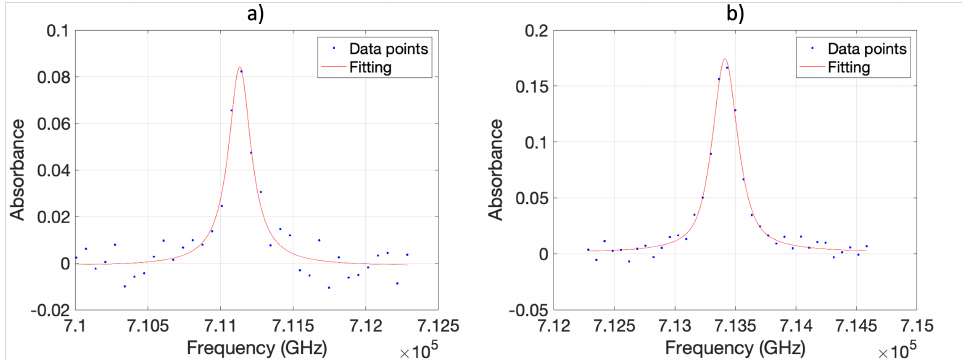
Figure A1. Example synthetic absorption spectra. ( a ) Voigt fitting parameters A F = 25.43, a F = − 3.62 × 10 − 5 GHz − 1 , B = − 0.00133, ∆ ν = 189.27 GHz, η = 0.999, ν = 711,131 GHz, F F 0, F 0, F M = 15.59%, SNR = 11.78 for the 5 S 1/2 → 6 P 1/2 transition. ( b ) Voigt fitting parameters A F = 62.77, a F = − 2.98 × 10 − 4 GHz − 1 , B F = − 0.00133 ∆ ν 0, F = 250.87 GHz, η F = 0.814, ν 0, F = 713,414 GHz, M = 10.12%, SNR = 23.66 for the 5 S 1/2 → 6 P 3/2